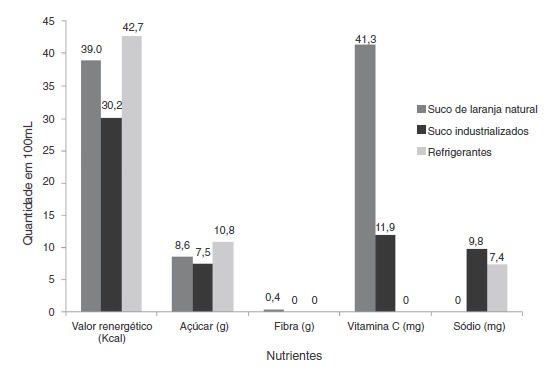
Comparação de valor energético, açúcar, fibra, vitamina C e sódio, na
composição centesimal do suco de fruta natural, sucos industrializados e
refrigerantes.12, 13-14